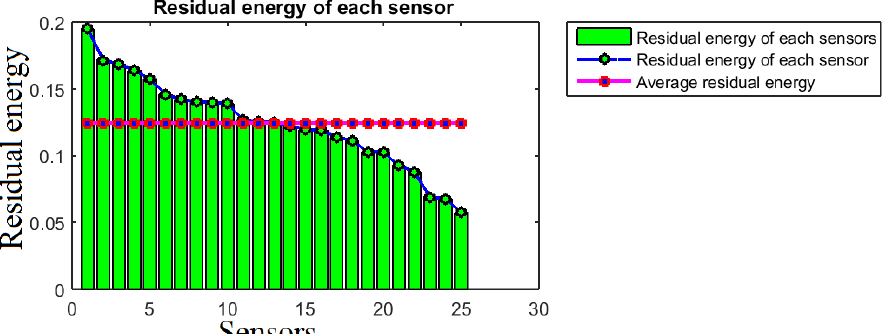
Figure 10. Residual energy of each sensor for 50